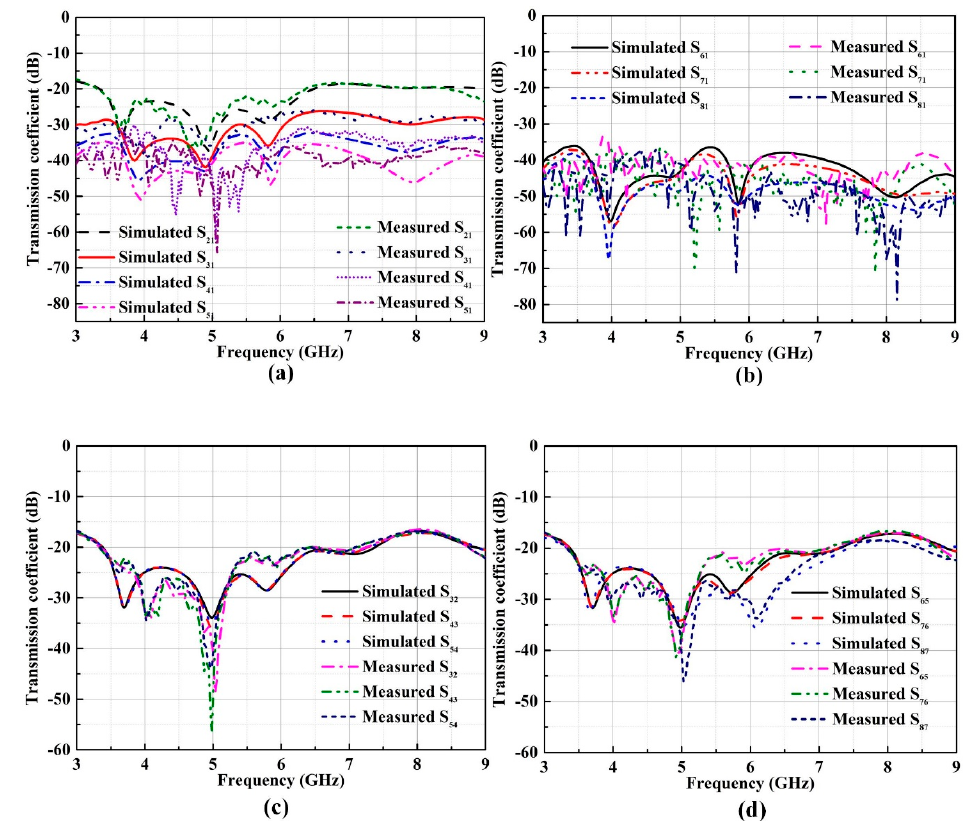
Figure 7. The simulation and test transmission coefficients of the proposed eight-element MIMO antenna. ( a ) Simulated and measured results of S 21 , S 31 , S 41 , S 51 ; ( b ) simulated and measured results of S 61 , S 71 , S 81 ; ( c ) simulated and measured results of S 32 , S 43 , S 54 ; ( d ) simulated and measured results of S 65 , S 76 , S 87 .